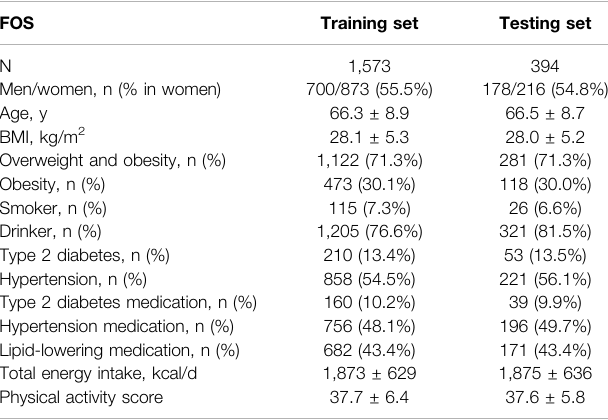
TABLE 1 | General characteristics of the